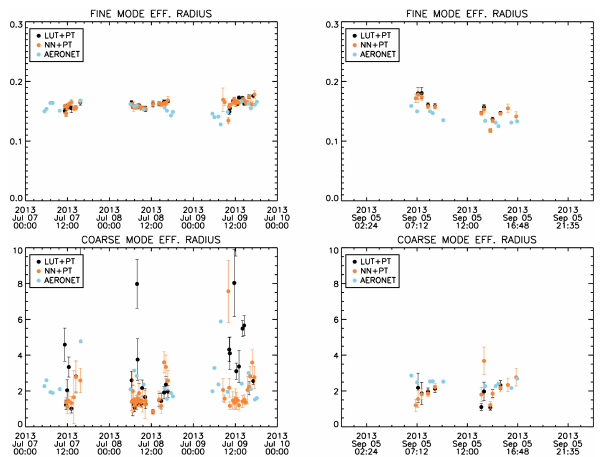
Figure 6. Time series of the fine- (above) and coarse-mode (below) effective radius retrieved by the LUT + PT scheme (black circles), the NN + PT scheme (orange circles), and the AERONET almucan- tar level 1.5 product (sky-blue circles): between 7 and 9 July 2013 (left) and on 5 September 2013 (right).